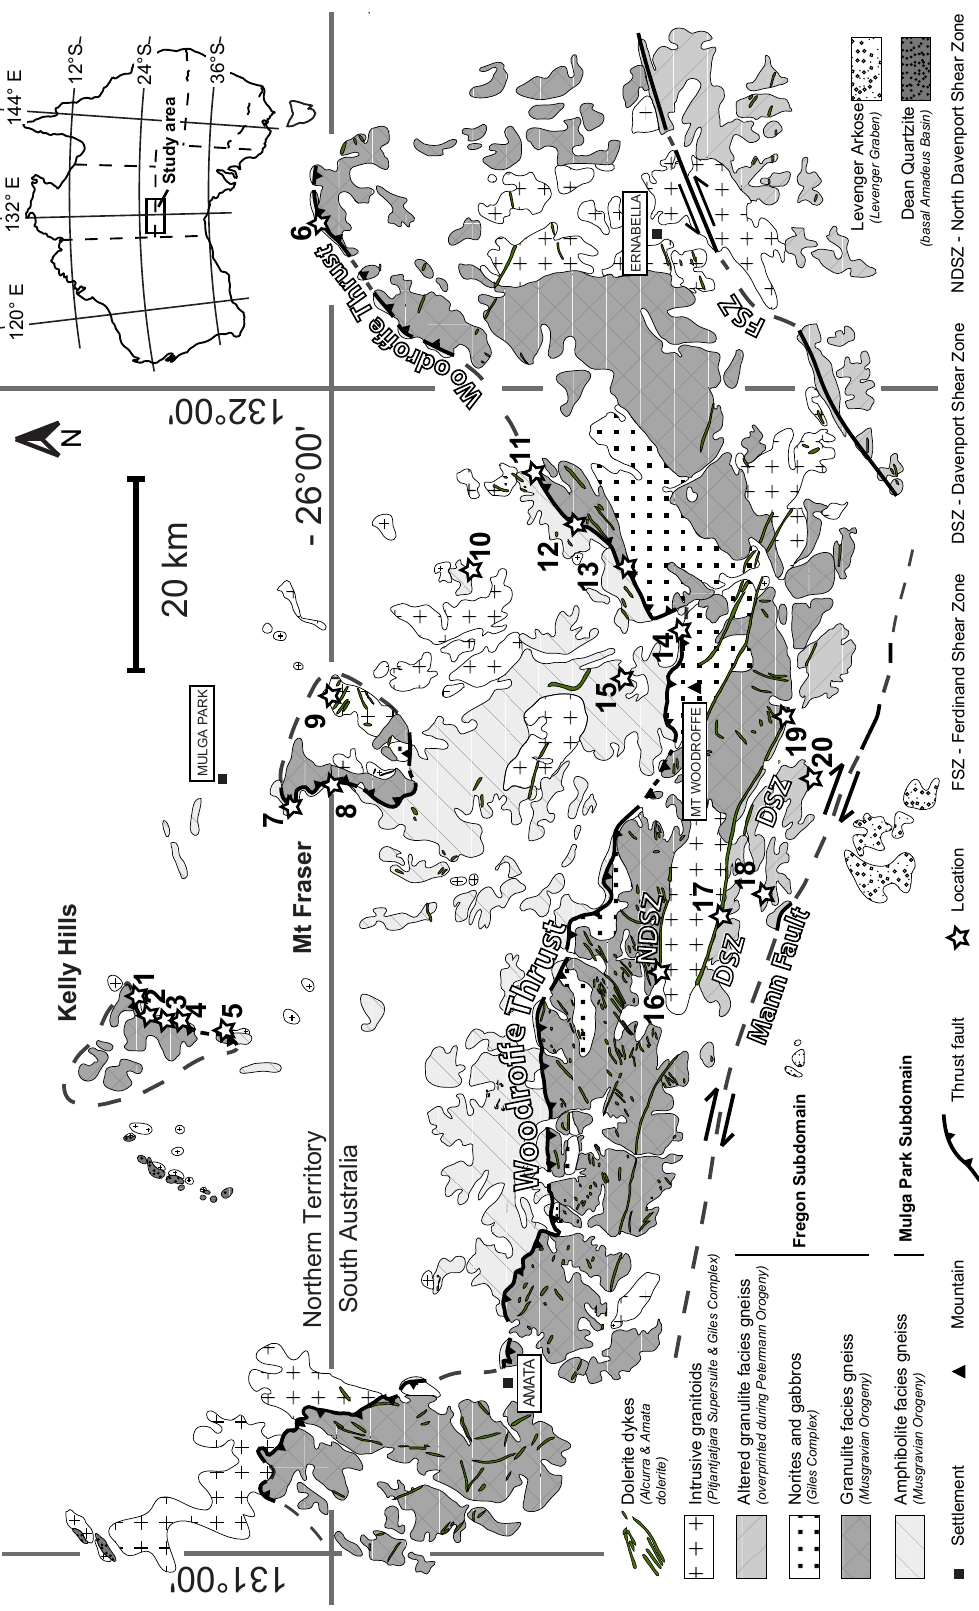
Figure 1. Geological map of the central Musgrave Block (modified after Major et al., 1967; Sprigg et al., 1959; Young et al., 2002).